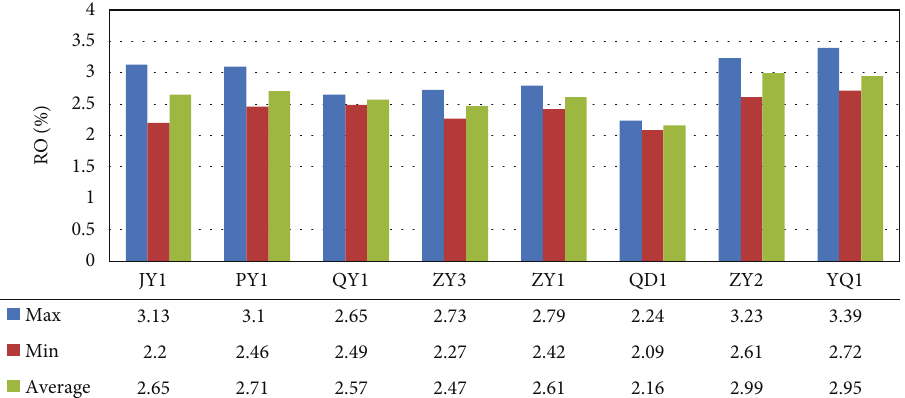
Figure 5: Comparison histogram of average value of thermal maturity (Ro) of organic matter in Wufeng-Longmaxi Formation in southeast Chongqing.